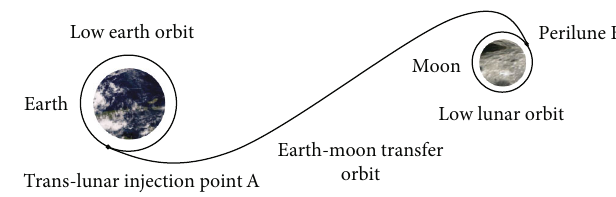
Figure 1: Schematic diagram of Earth-Moon transfer